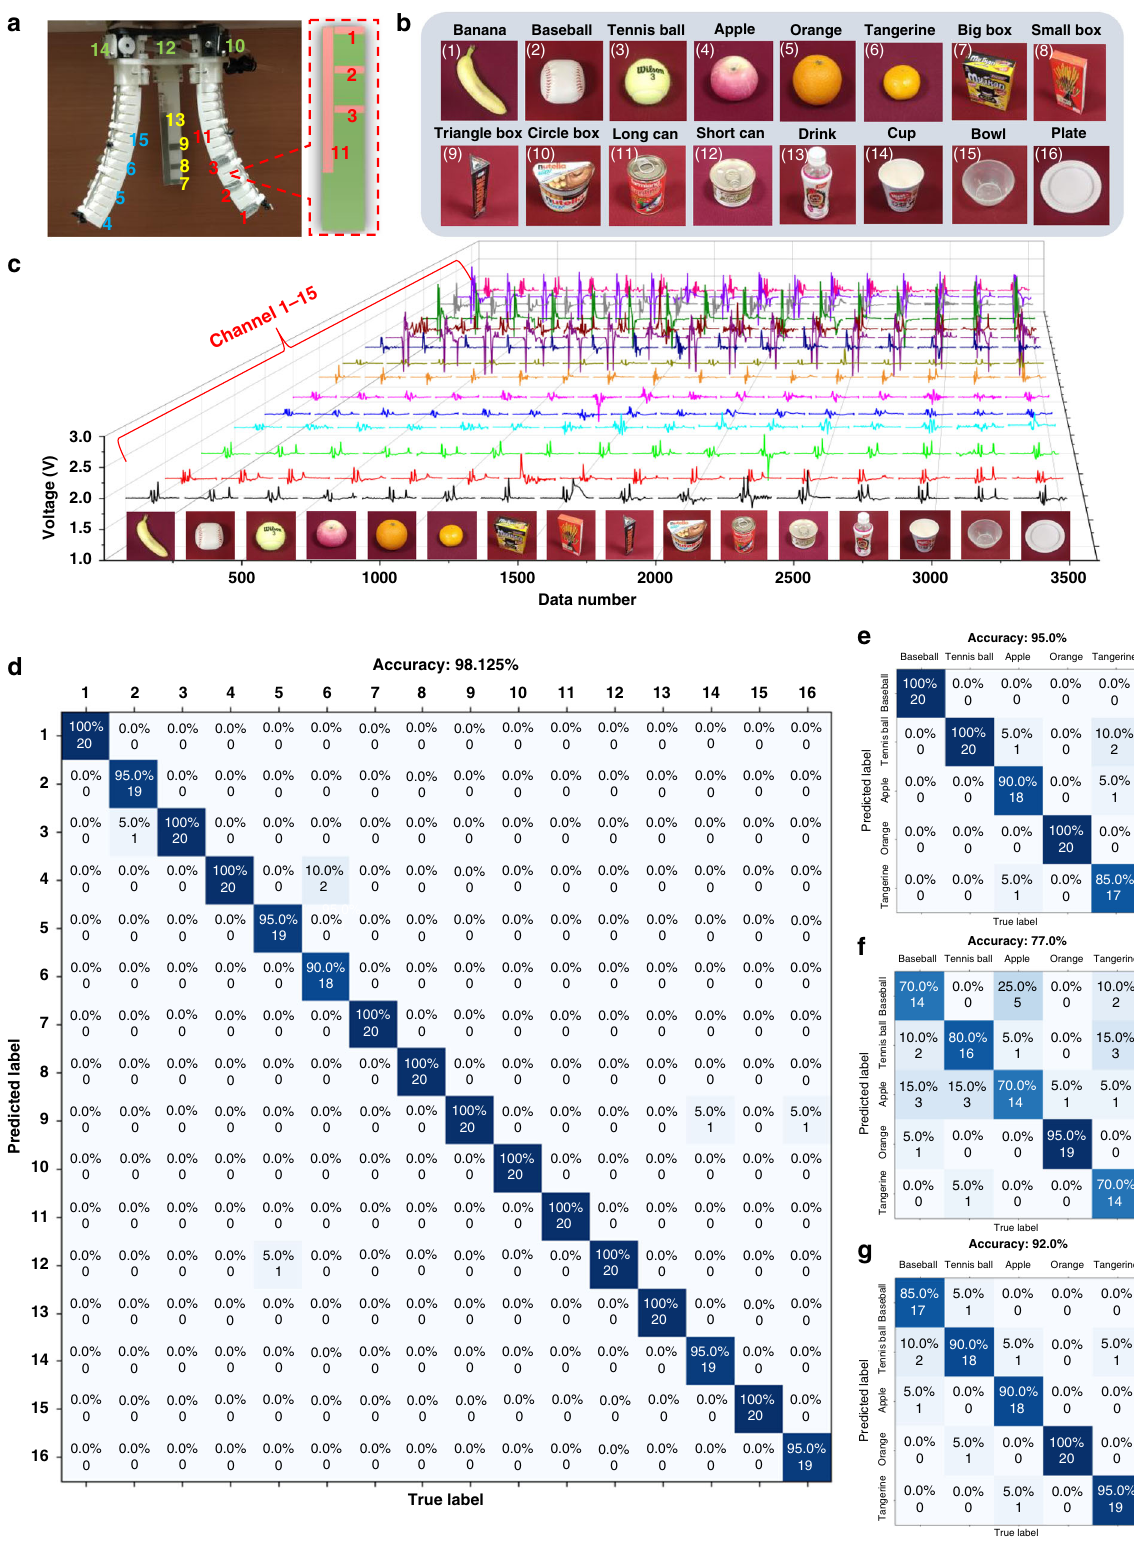
Fig. 5 Enhanced object recognition system via machine learning technology. a The channel arrangement of integrated sensors for collecting data. b The 16 objects to be gripped and recognized. c 3D plots of the robotic sensor outputs corresponding to different objects. d The confusion map for machine learning outcome of 16 objects with 15 channels. The comparison of confusion maps for machine learning outcomes of sphere objects with e all of 15 channels on both the length TENG (L-TENG) and tactile TENG (T-TENG) sensors, f pure L-TENG sensors (3 channels), and g pure T-TENG sensors (12